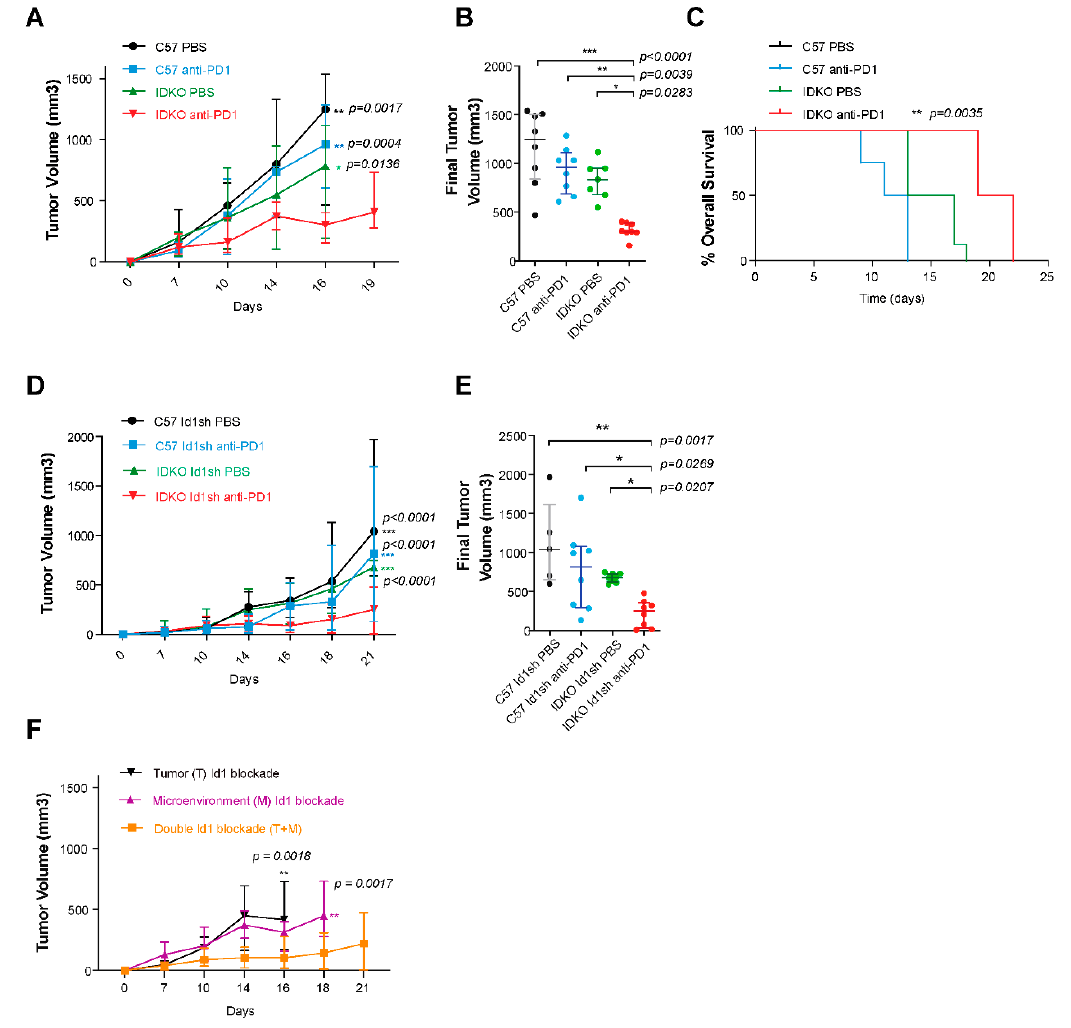
Figure 3. E ff ect of combined PD-1 and Id1 blockade in both tumor microenvironment (IDKO mice) and tumor microenvironment along with tumor cells (LLC) in a LUAD syngeneic model. ( A ) Tumor growth LLC parental cells injected in Id1 +/+ (C57BL / 6J) or Id1 - / - (IDKO) mice. ( B ) Final tumor volumes of the same four mice groups as in A at days 16 and 19 (IDKO mice injected treated with anti-PD-1 therapy) post-tumor injection (Id1 - / - / anti-PD-1: 303.1 [291–387.8] mm 3 ; Id1 - / - / DPBS: 834.6 [678.1–961.1] mm 3 , p = 0.0283; Id1 +/+ / anti-PD-1: 961.1 [686.7–1112 ] mm 3 , p = 0.0039; Id1 +/+ / DPBS: 1248 [839.3–1502] mm 3 , p < 0.0001). ( C ) Kaplan-Meier plot of the OS of mice in A (median survival per group in days: Id1 - / - / anti-PD-1: 20.5; Id1 - / - / DPBS: 15; Id1 +/+ / anti-PD-1: 12; Id1 +/+ / DPBS: 11; p = 0.0035). ( D ) Combined blockade of PD-1 and Id1 silencing both in the tumor microenvironment (IDKO mice) and LLC cells